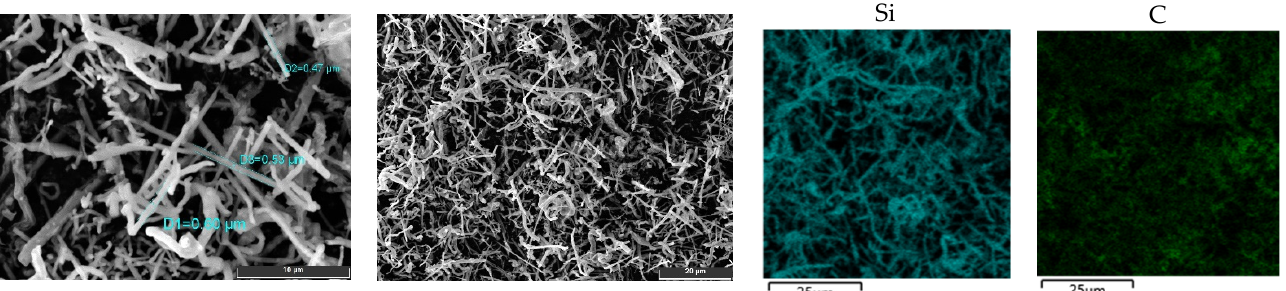
Figure 5. SEM-image and the elements distribution in a Si sample obtained by electrolysis of the (wt%) 98KCl-2K 2 SiF 6 melt at a temperature of 780 °C and a cathode current density of 25 mA cm − 2.